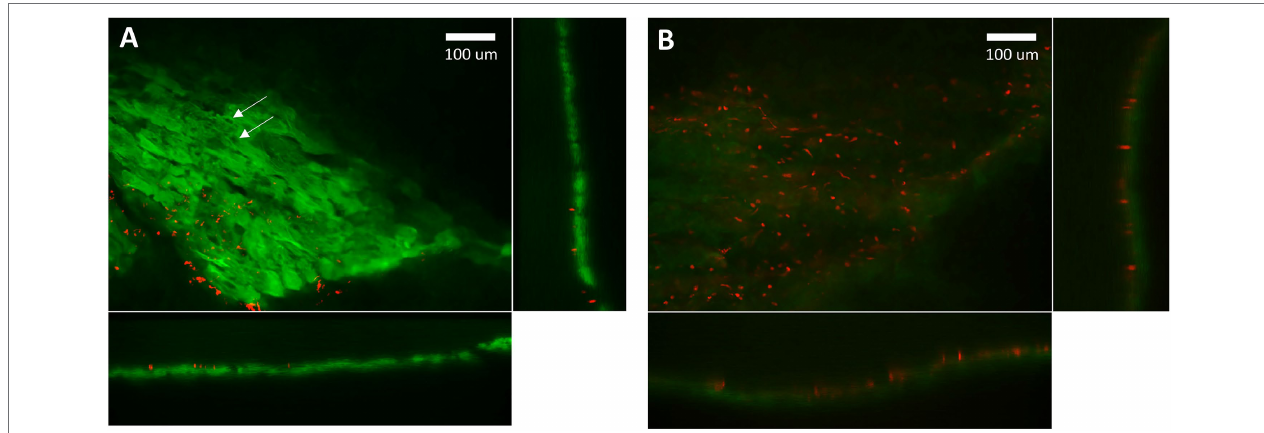
FIGURE 4 | Confocal microscopy imaging of cell viability after slicing. (A) Green indicates cytosol of intact myocytes within a cardiac slice. Red indicates detection of DNA, which is only possible if the membrane has been disrupted. The localized absence of green within a myocyte indicates intact nuclei (arrows). DNA fragments and disrupted membranes appear limited to the edge of the slice where a razor blade was used to cut the tissue. We estimate 40% intact myocytes on the edges and effectively 100% intact for myocytes further than 30 mm from an edge. (B) Red indicates DNA detected in “dead” myocytes whose membranes have been disrupted by detergent. The absence of green further attests to a lack of intact membranes. Settings used for acquisition and display of these two images were the